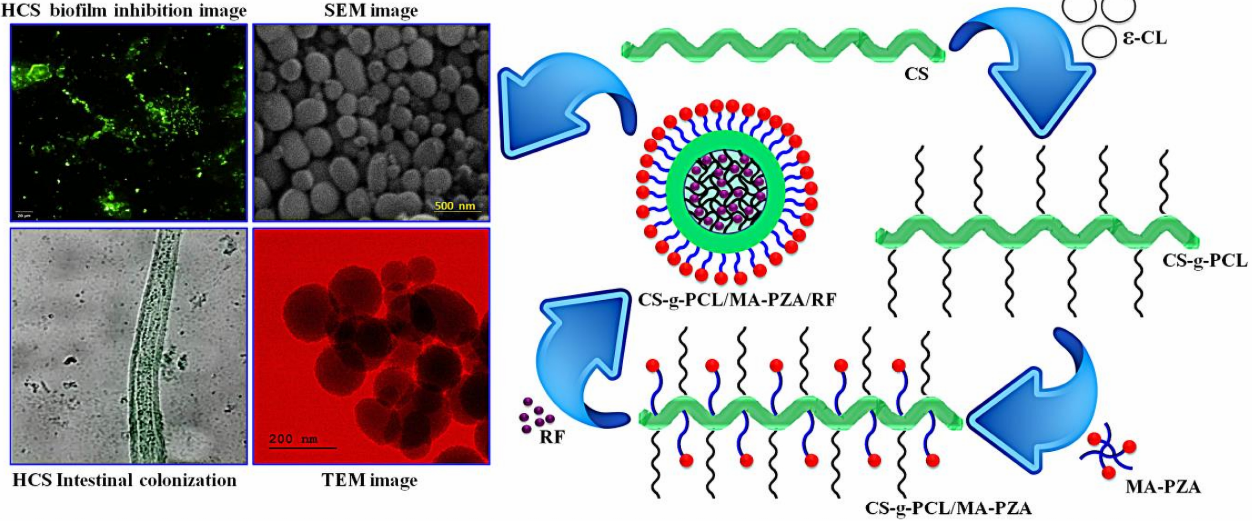
Figure 6. Schematic illustration for the preparation, characterization and application of CS-g- PCL/MA-PZA/RF micelles. Reprinted with permission from ref. [95]. Copyright (2020)